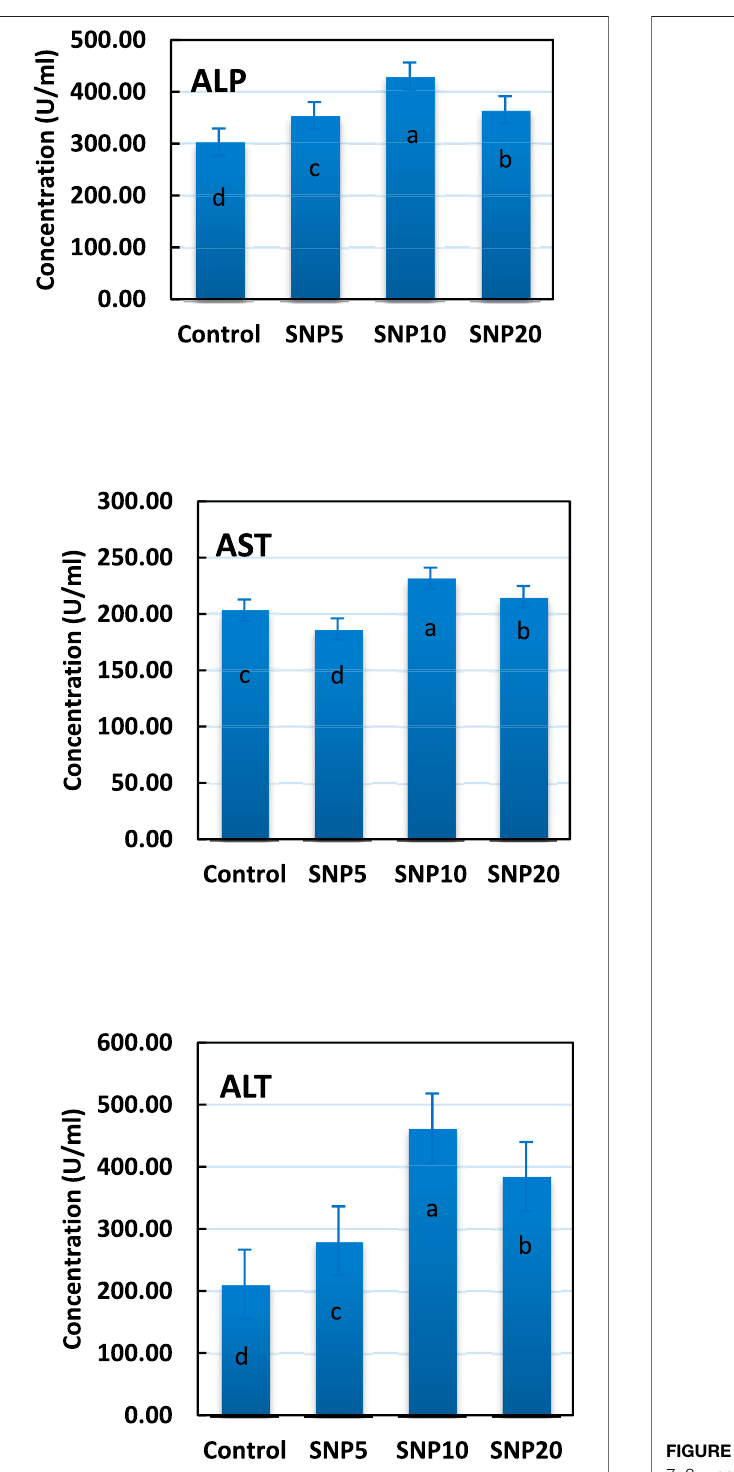
FIGURE 6 | Activity of alkaline phosphatase (ALP), aspartic transaminase (AST), and alanine aminotransferase (ALT) enzymes in liver tissue of 7 – 8-week-old rats after 96-h gavaging with different levels of silica nanoparticles including zero (asthe control), 5(SiNP5), 10(SiNP10), and 20 (SiNP20). Different letters indicate signi fi cant differences ( p < 0.05) (A – C) .